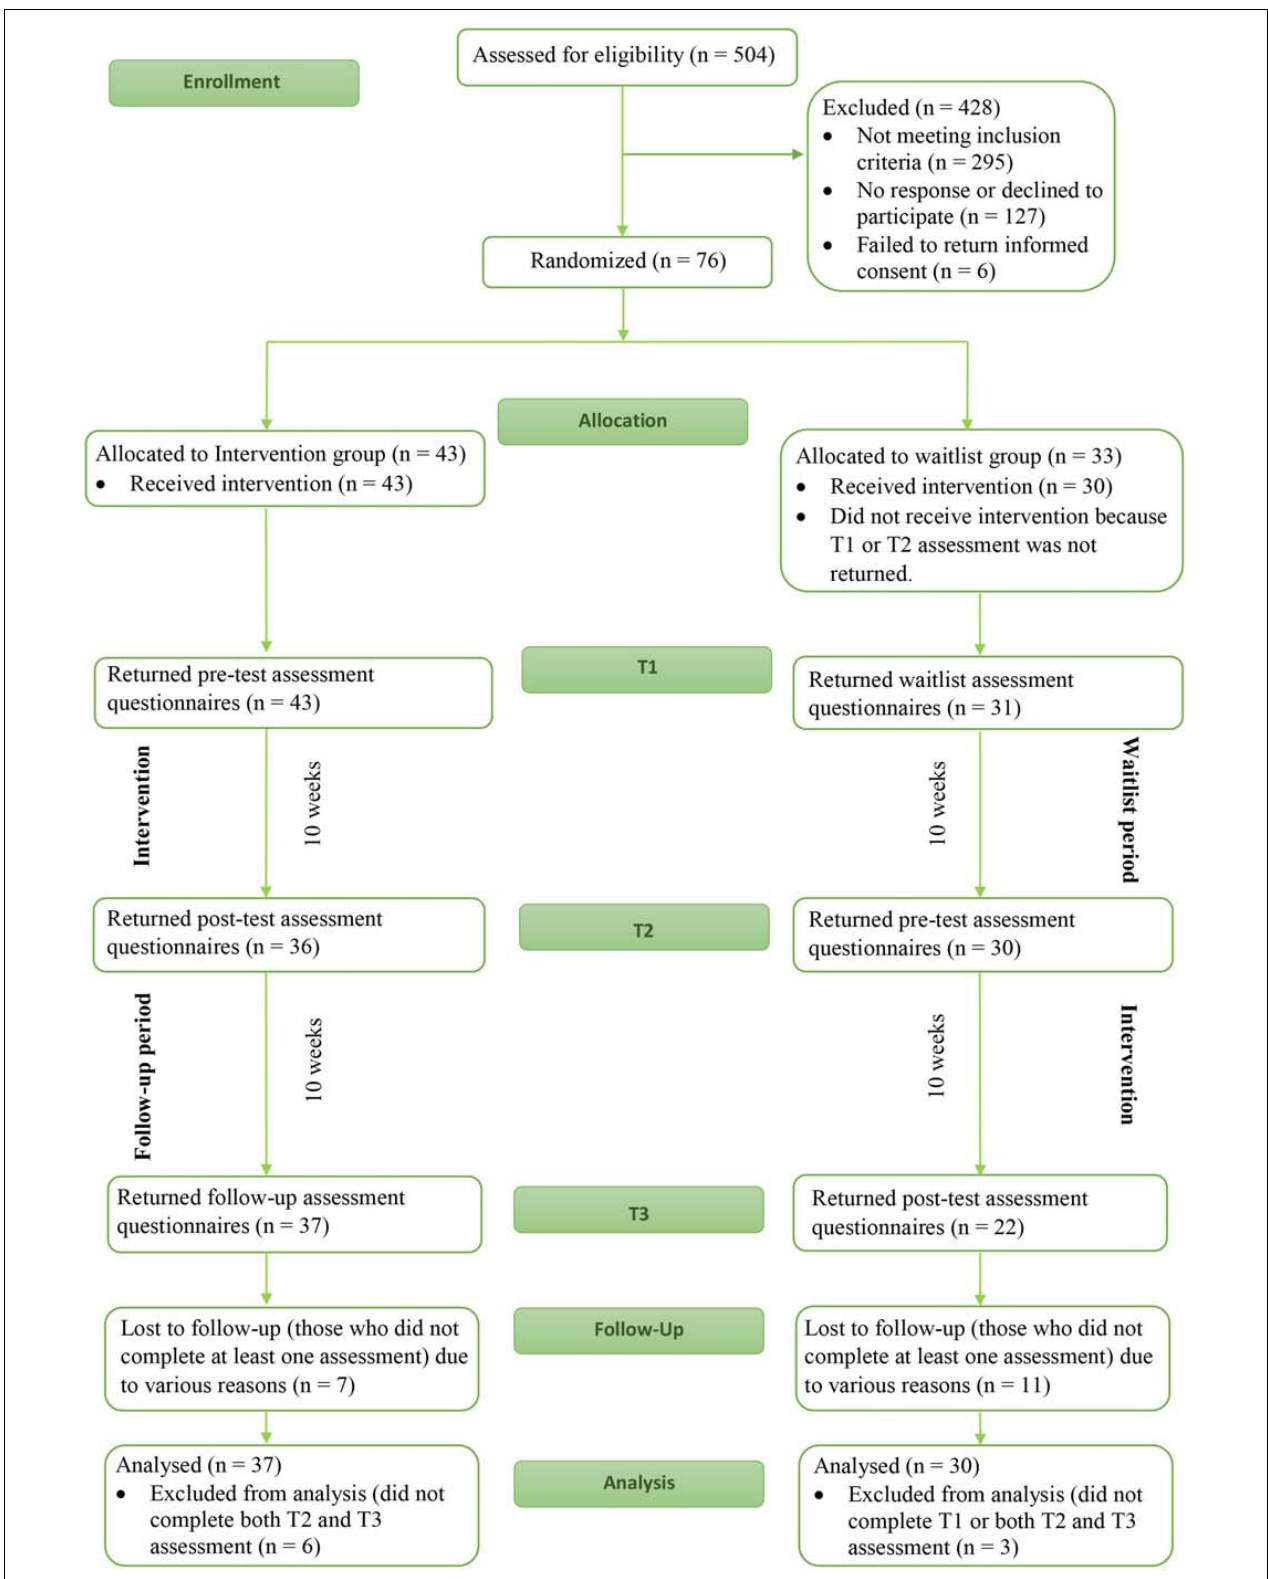
FIGURE 1 | Flowchart for the participating women in the current